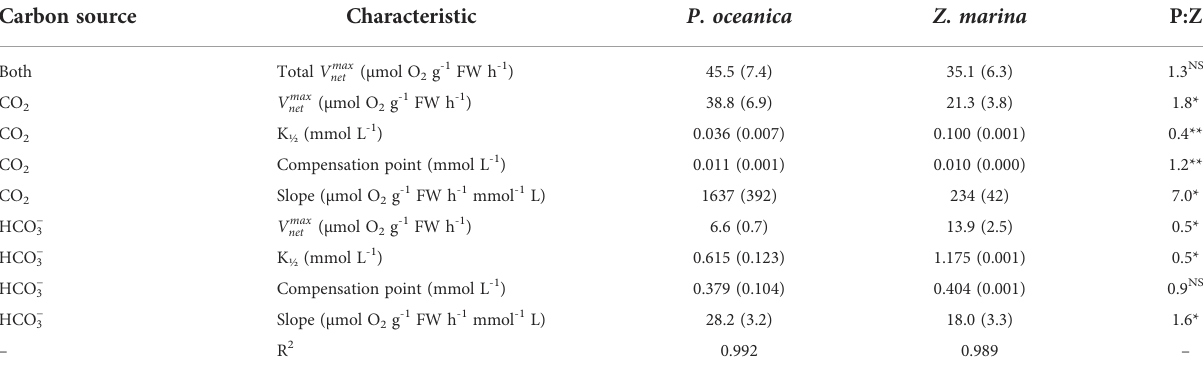
TABLE 2 Kinetic characteristics of CO 2 and HCO 3 - uptake by P. oceanica and Z. marina determined using the model in equation 1. Carbon source Characteristic